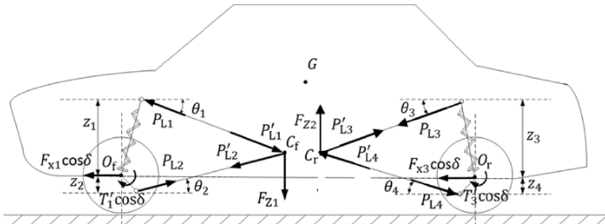
Figure 2. The force analysis of vehicle longitudinal plane.